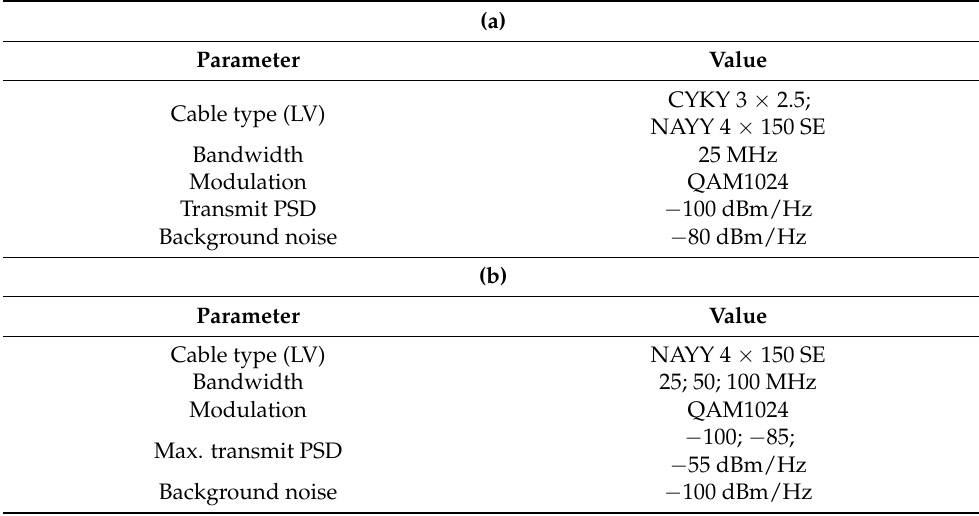
Table 10. Input channel parameters of ( a ) cable type sweep; ( b ) bandwidth